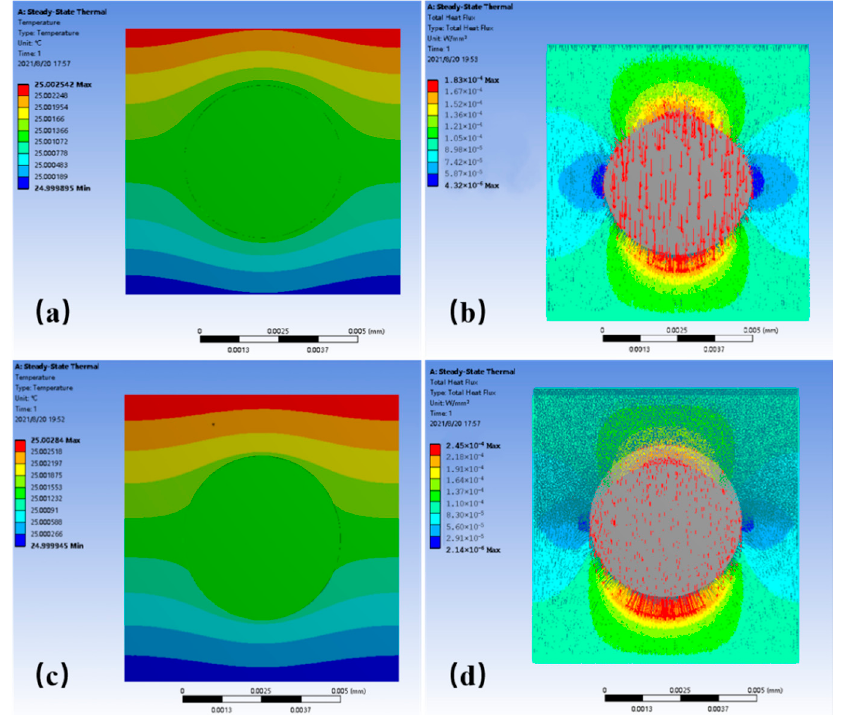
Figure 5. The simulations results of a thermally conductive unit for the LLDPE/Al 2 O 3 composite when the volume fraction of Al 2 O 3 was 9.8% and the average particle size of Al 2 O 3 was 5 μ m: ( a , c ) the temperature contour; ( b , d ) the thermal flux vector graph; ( a , b ) without interface layer; ( c , d ) with interface layer.